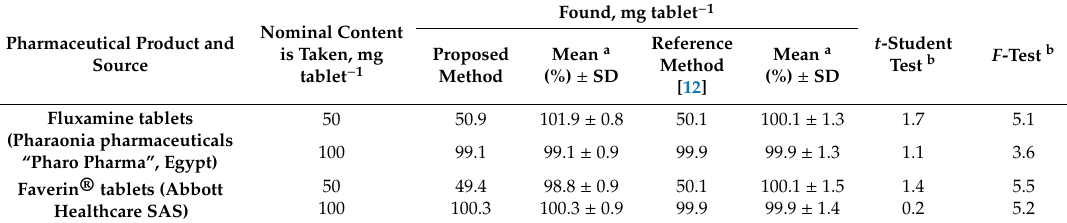
Table 3. FLV determination in pharmaceutical preparations using the proposed membrane sensor.